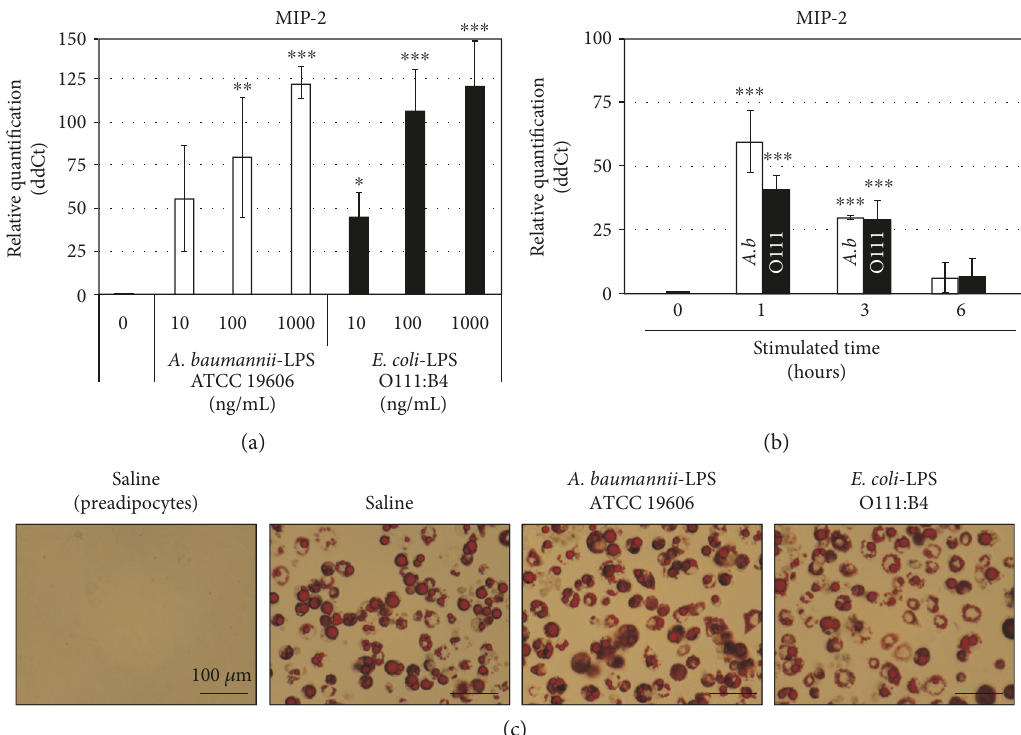
Figure 3: Induction of MIP-2 by A. baumannii -LPS in 3T3-L1 adipocytes. The dose-dependent e ff ect of A. baumannii -LPS was examined via the MIP-2 expression in adipocytes. The adipocytes were incubated for 1 h in fresh medium containing 10, 100, or 1000 ng/mL of A. baumannii -LPS (ATCC 19606), (a) E. coli -LPS (O111:B4), or saline and were subjected to real-time PCR analyses for the detection of MIP-2 mRNA. (b) MIP-2 expression in adipocytes was measured at the indicated time points following treatment with 100ng/mL A. baumannii -LPS (ATCC 19606) or 100ng/mL E. coli -LPS (O111:B4). The expression of MIP-2 is presented as the ratio of viable MIP-2 expression in adipocytes treated with LPS versus those treated with saline at the indicated time points. All experiments were performed in triplicates, and the results are presented as the mean ± SD. (c) The microscopic images ( × 280 magni fi cation) of 3T3-L1 adipocytes treated with LPS on day 8 via Oil-Red-O staining. 3T3-L1 adipocytes were di ff erentiated in 35mm dishes and subsequently stimulated with the LPS derived from several bacterial strains (1000ng/mL) for 24h. The morphological changes in adipocytes caused by LPS (1000ng/mL) were assessed by optical microscopy. ∗ P < 0 05 ; ∗∗ P < 0 01 ; ∗∗∗ P < 0 005 (compared to adipocytes without LPS